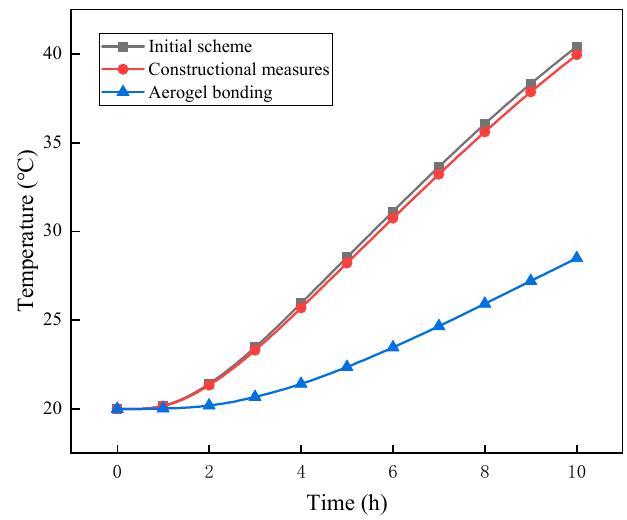
Figure 16. Temperature–time curves at point A for different forms of heat bridge.